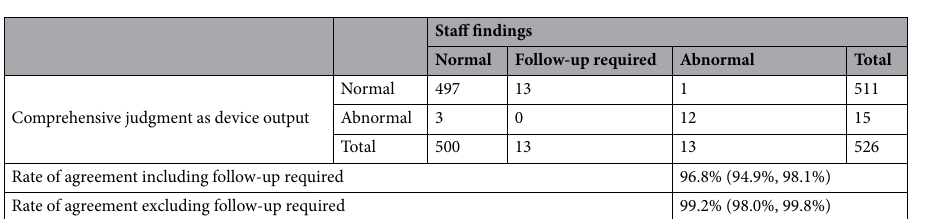
Figure 5. Comparison of the results from the blood flow deficiency algorithm and physician findings. The risk rate calculated for each parameter was stratified by the findings of the medical staff for each patient. A statistically significant difference was seen between the normal and abnormal cases for the pulse wave parameter in Trial 1. Because we noticed that in a clinical setting, there are some cases that are hard to determine as either normal or abnormal, in the next trial, we added follow-up required as an alternative finding for the physician. In Trial 2 ( n = 45), a statistically significant difference was seen between the normal and abnormal cases for all three parameters (pulse wave, colour, and temperature). A significant difference was also seen between the neither normal nor abnormal (follow-up required) and the abnormal cases for the pulse wave and temperature parameters.